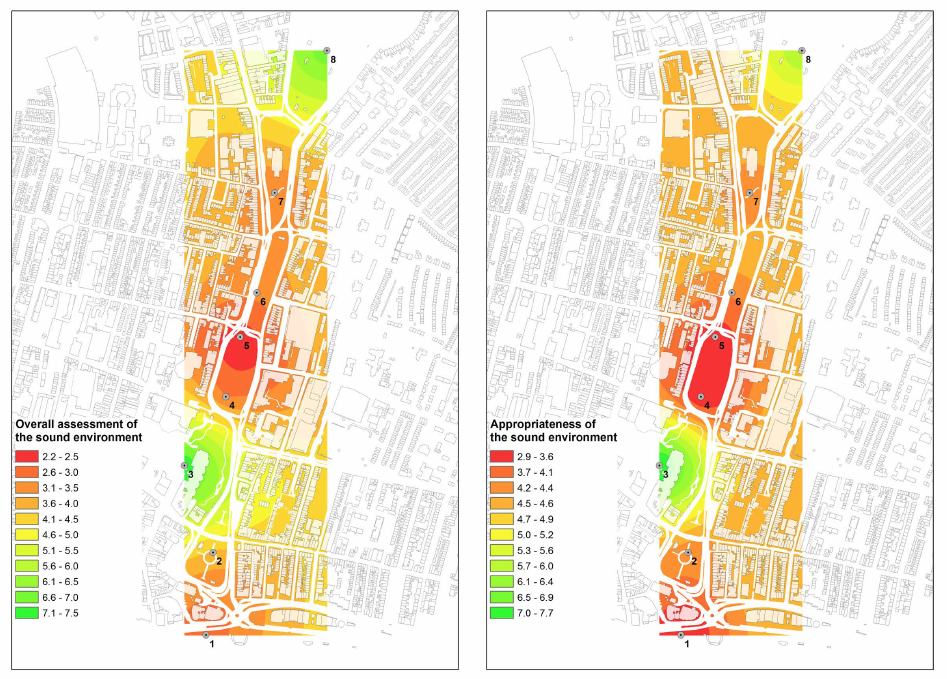
Figure 8: Soundscape maps for the overall assessment of the sound environment (left) and the appropriateness of the sound environment to the place